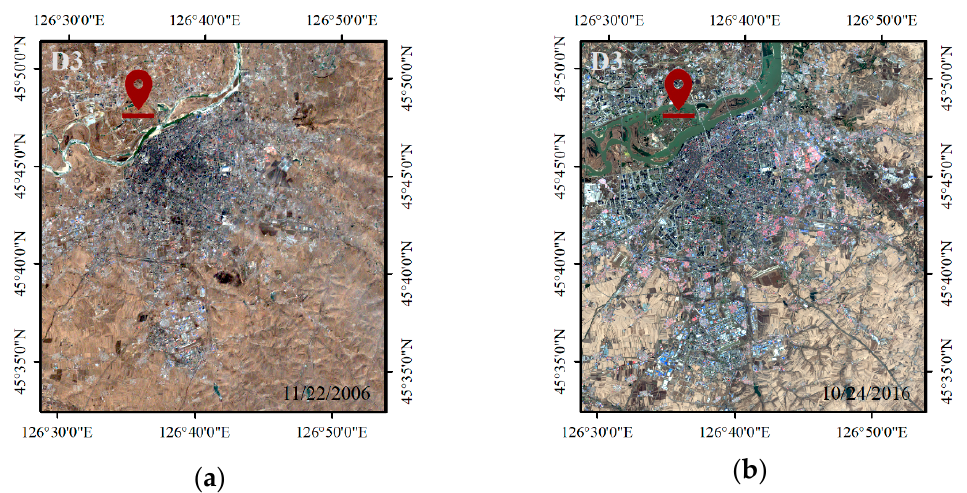
Figure 6. Change in the river area in D3 on the Landsat image. ( a ) Landsat image in 2006; ( b ) Landsat image in 2016.